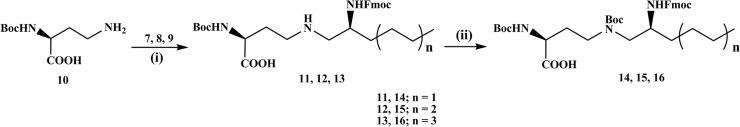
Synthesis of triamino acid building blocks with varied lipophilic tails.(i) NaBH3CN, 1% AcOH in methanol, rt, 18 h (ii) (Boc)2O, water:dioxane (v/v, 1:1), 10% aq. soln. of Na2CO3, rt, 18 h.